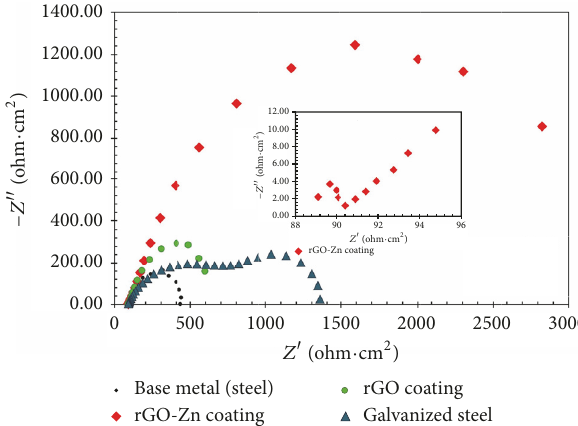
Figure 12: Nyquist plots of rGO-Zn coating, bare steel, galvanized steel, and rGO coating immersed in 0.1 M KCl solution at frequency range of 10 −3 to 10 5 Hz with 5 mV ac amplitude and OCP condition (stability time: 30 min).